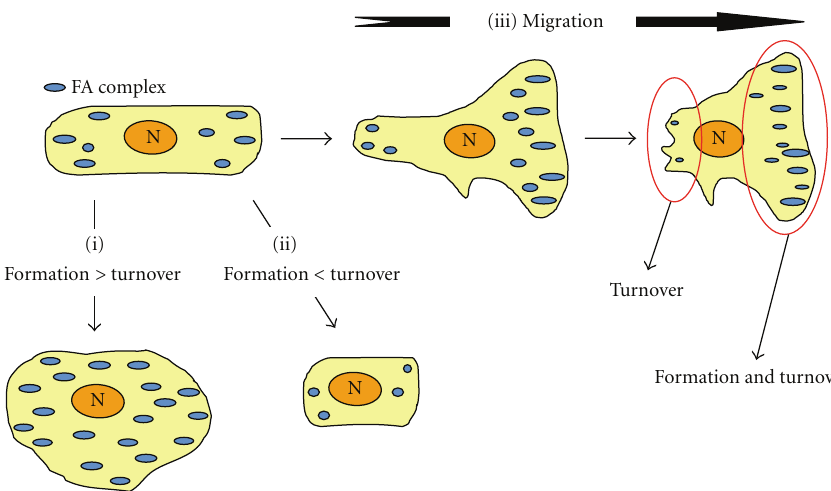
Figure 2: The formation and turnover of FAs during cell migration. The formation and turnover of FAs is crucial for cell adhesion to the ECM. A higher ratio of formation relative to turnover leads to stable adhesion (i). On the other hand, a higher ratio of turnover relative to formation leads to unstable adhesion (ii). During cell migration, both rapid formation and turnover of FAs are required at the leading edge of cell migration, whereas turnover of FAs is predominant at the rear